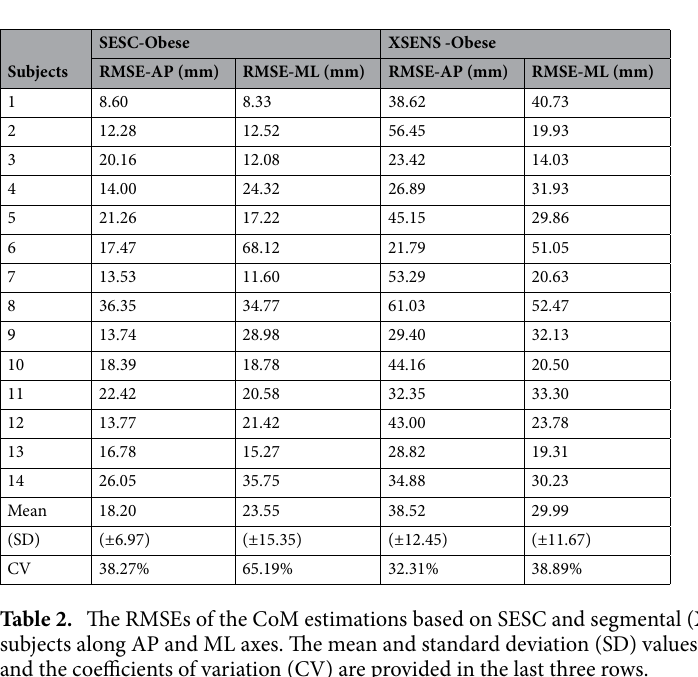
The resultant RMSE of the CoM estimations of the Obese group are summarized in Table 2. The RMSE values for the SESC estimations ranged between 8.6 mm and 36.35 mm along the AP direction with an average of 18.20 (±6.97) mm, and between 8.33 mm and 68.12 mm along ML direction with an average of 23.55 (±15.35) mm. For the segmental method (XSENS), the RMSE values ranged between 21.79 mm and 61.03 mm along the AP The box and whisker plots shown in Fig. 2, present the RMSE values of the CoM estimations based on SESC and XSENS for the Fit and Obese groups. For both groups, along the AP-axis (Fig. 2a), it is clear that the RMSE values belonging to SESC are significantly lower than those of XSENS ( p = 0.001). On the other hand, there is no statistically significant difference in the comparison of the RMSE values of SESC estimations for the Fit and Obese